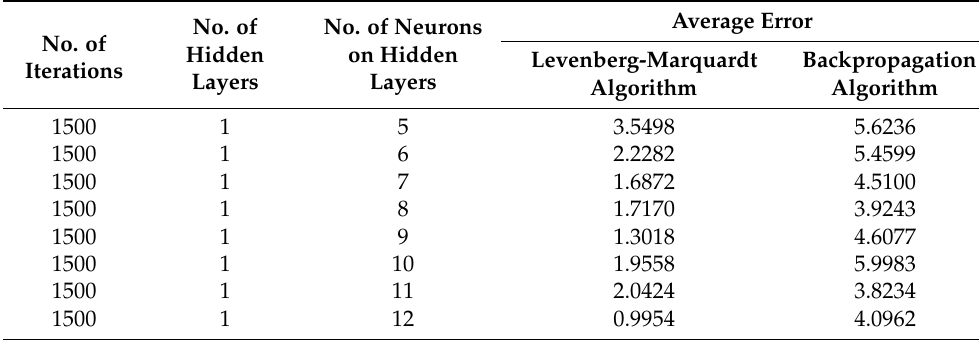
Table 2. Simulation results obtained with the original data using the Levenberg-Marquardt and the Backpropagation algorithms